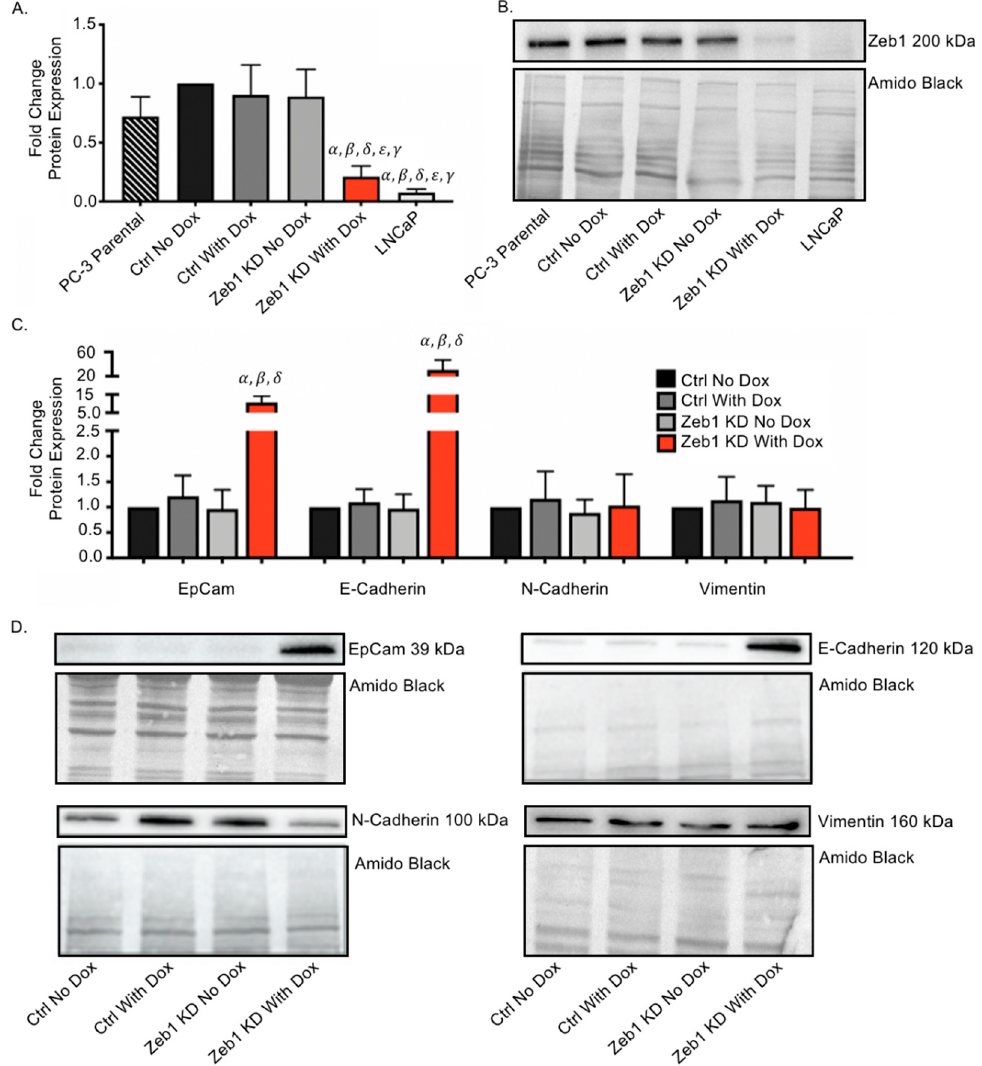
Figure 1. Inducible knockdown of Zeb1 in PC-3 human prostate cancer cells results in enhanced expression of epithelial proteins. Mesenchymal human PC-3 prostate cancer cells were engineered to knockdown expression of the master epithelial-to-mesenchymal (EMT) regulator Zeb1 using the SMARTvector inducible lentiviral shRNA system (Dharmacon), which features Tet-on ® induction of the target shRNA in the presence of doxycycline (Dox). ( A , B ) Immunoblot analysis of Zeb1 protein expression in the presence or absence of Dox (72 h) in Zeb1 KD ( Zeb1 knockdown), control (ctrl) PC-3 cells, or LNCaP cells. ( C , D ) Immunoblot analysis of E-Cadherin, EpCAM, Vimentin and N-cadherin in Zeb1 KD or ctrl cells 72 h after Dox induction. Representative immunoblots are shown and amido black staining of total protein was used as a loading control. Quantitative data is presented as mean ± standard error of the mean (SEM) fold-change in expression relative to ctrl cells ( n = 3). α = significantly different than ctrl no Dox. β = significantly different than ctrl with Dox. δ = significantly different than Zeb1 KD no Dox. γ = significantly different than PC-3 parental ε = significantly different than LNCaP ( p ≤ 0.05).